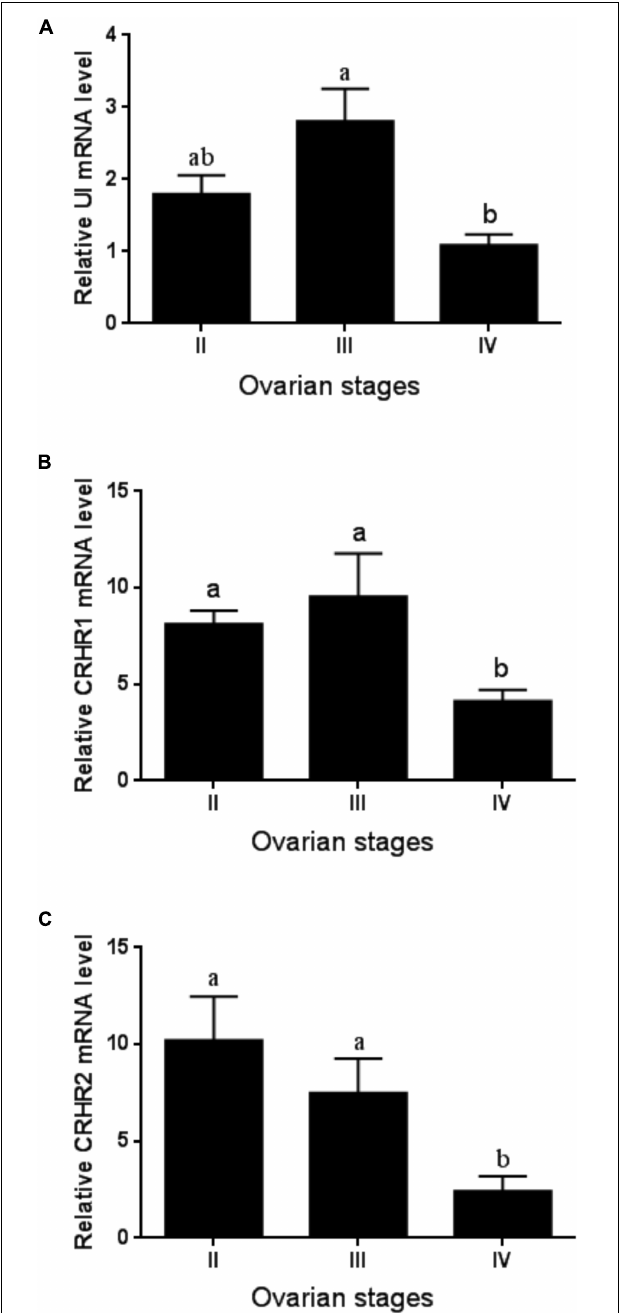
FIGURE 2 | The expression of UI (A) , CRHR1 (B) , and CRHR2 (C) mRNA at the ovary level during ovarian development. Values are mean ± SEM, n = 4. Means with different letters within a column are significantly different P < 0.05.